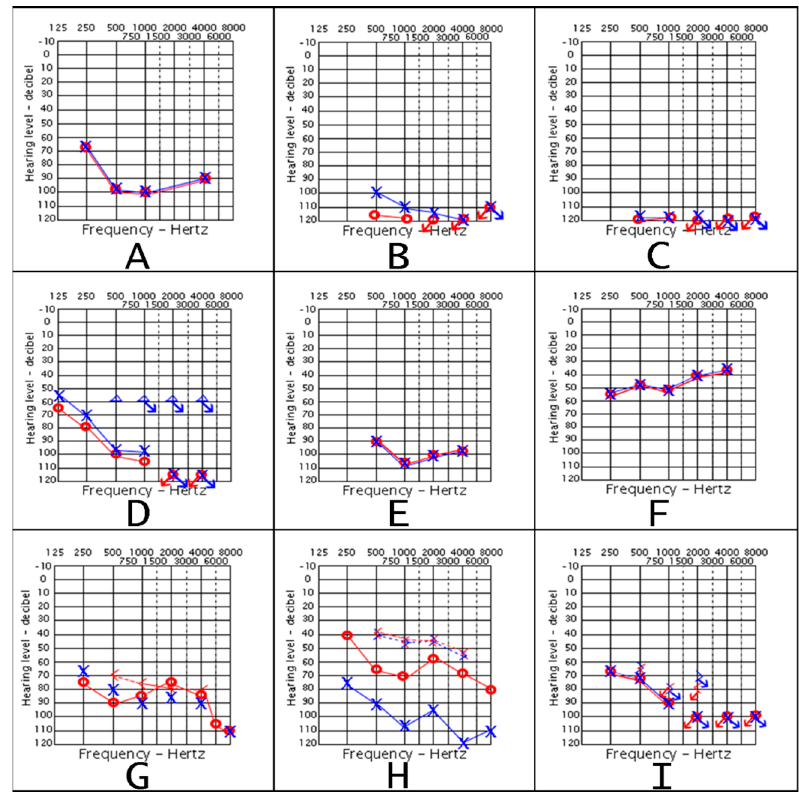
Figure 2. Audiograms of selected family members. Audiograms of F1: IV3 (c.165 − 1G>C) are shown in ( A – C ) at the age of 1 year and 7 months, 6 years, and 17 years, respectively. ( D ) for F1: IV-2 at the age of 3 years. Audiograms of F1: IV − 5 are depicted in ( E , F ) before and after cochlear implant at the age of 4 and 5 years, respectively. ( G ) for F2 (p.Gly102Arg and p.Trp482*): IV − 1 at the age of 7 years. ( H ) for F2: IV-3 at the age of 5 years. ( I ) for F3 (c.165 − 1G>C): V − 4 at the age of 20 years. The symbols of the red circles and the blue crosses represent the readings of earphones unmasked air conduction of the right and left ear, respectively. Blue triangles for the masked air conduction readings of the right ear. The (<) and (>) symbols are used to represent the reading of the mastoid unmasked air conduction of the right and left ears, respectively. Arrows on any of the symbols represent no re- sponse.